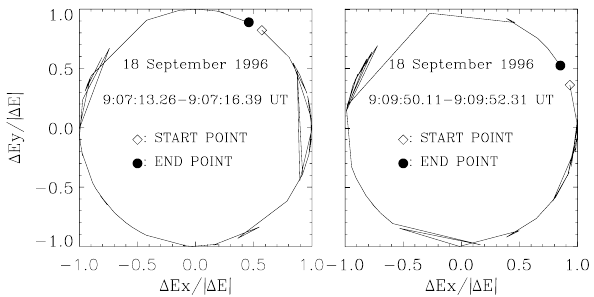
Fig. 5. Hodograms of the two perpendicular components of the cavity electric field at two different time periods on 18 Septem- ber 1996, where the | 1E | = | E − <E> | , 1E x = E x − <E x > , and 1E y = E y − <E y > with < > being the average over the time pe-